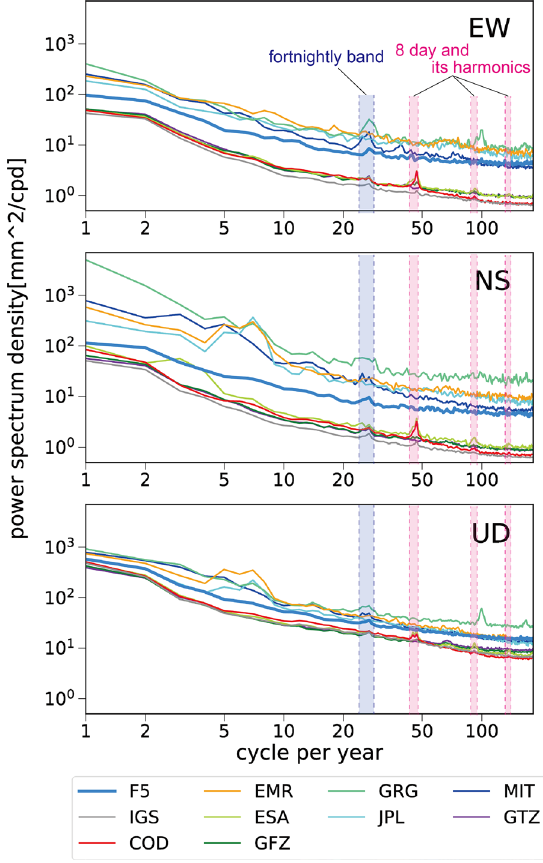
Fig. 7 Power spectra for the station coordinates derived from the individual processing. The power spectra in 365 days were stacked over the stations and period from 2003 to 2021 shifting an interval of half a year. Except for GRG and GTZ, the repro2 solution is used up to 2014. ULR was eliminated because the noise level was too high to draw a consistent scale. The blue hatched area indicates the fortnightly band. The pink hatched area indicates the period of 8 days and its second and third